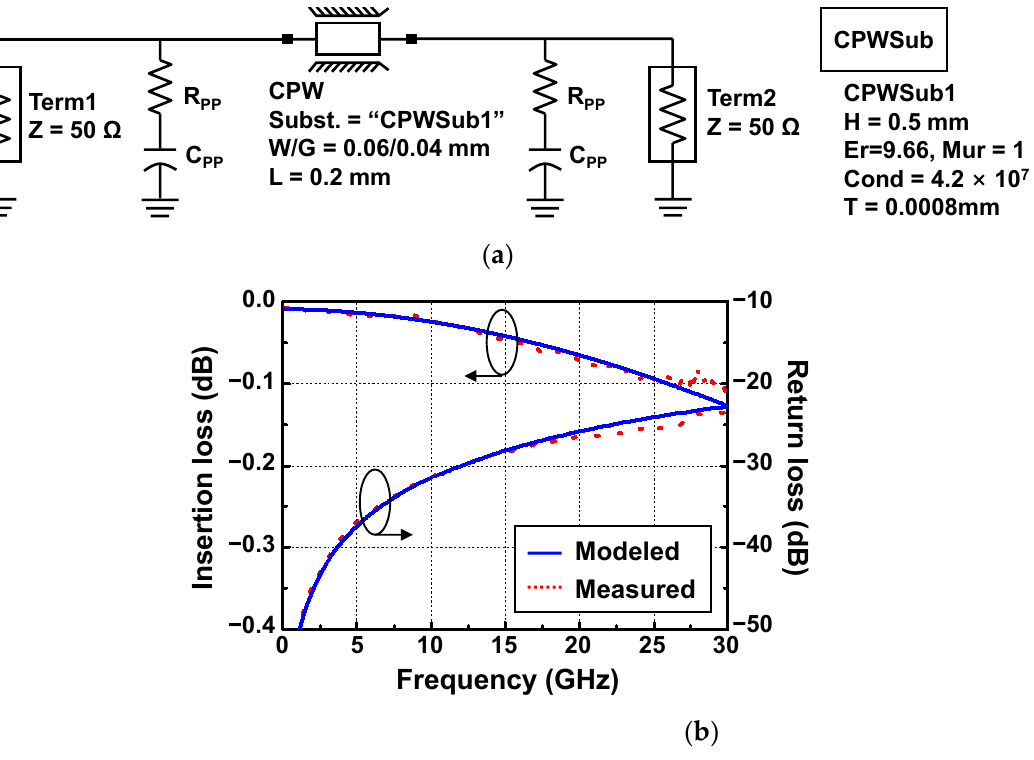
Figure 10. De-embedding for an RF pad region of CPW lines: ( a ) RF modelled circuit diagram of a thru pattern; ( b ) measured and modeled results for S-parameter of the thru pattern.